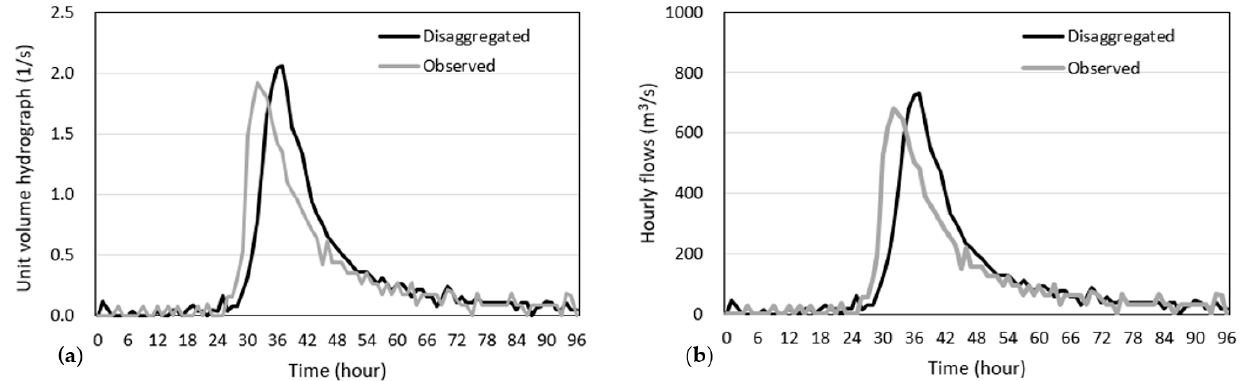
Figure 7. Comparison of the observed and disaggregated flows at Imha-dam. ( a ) unit volume hydrographs ( b ) scaled